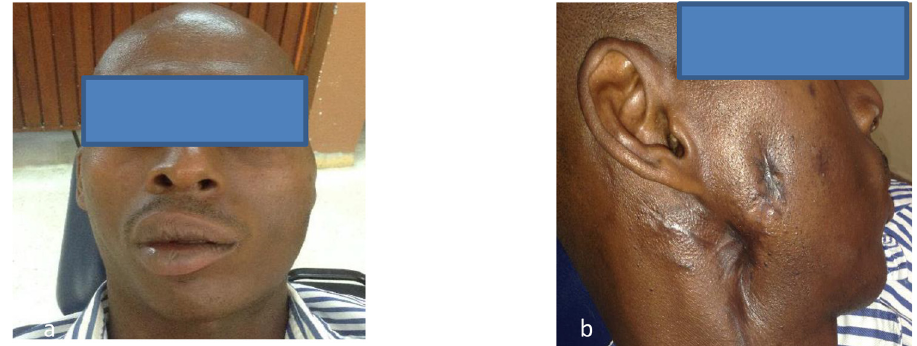
Fig. 3. Sequela of odontogenic mandibular osteitis: facial asymmetry (a) and unsightly scarring from the mandibular angle (b).